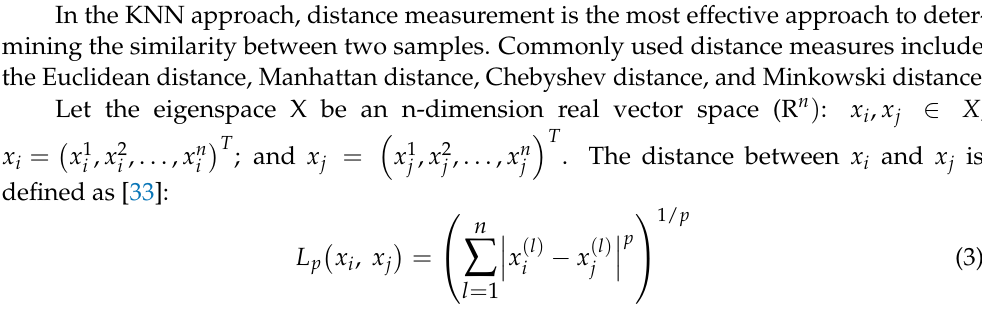
Figure 2. RLA–KNN approach.